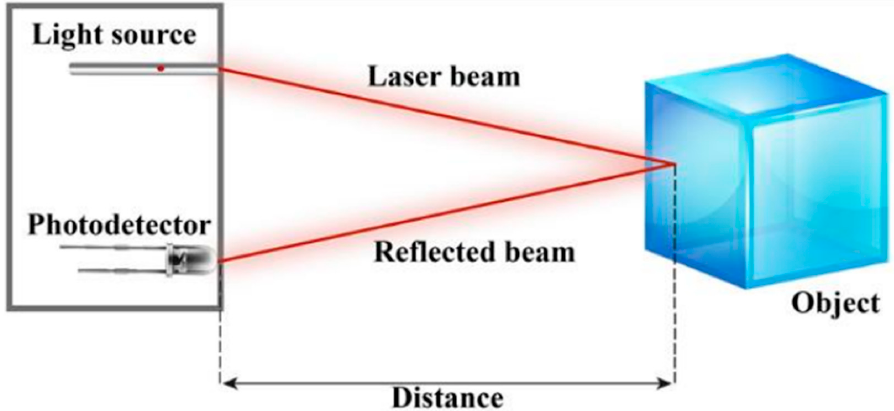
Figure 1. LiDAR ToF technique: The sensor shoots a laser beam from its light source and triggers a time counter, so, when the photodetector receives the returning signal, the system registers the total time of the laser flight [29].